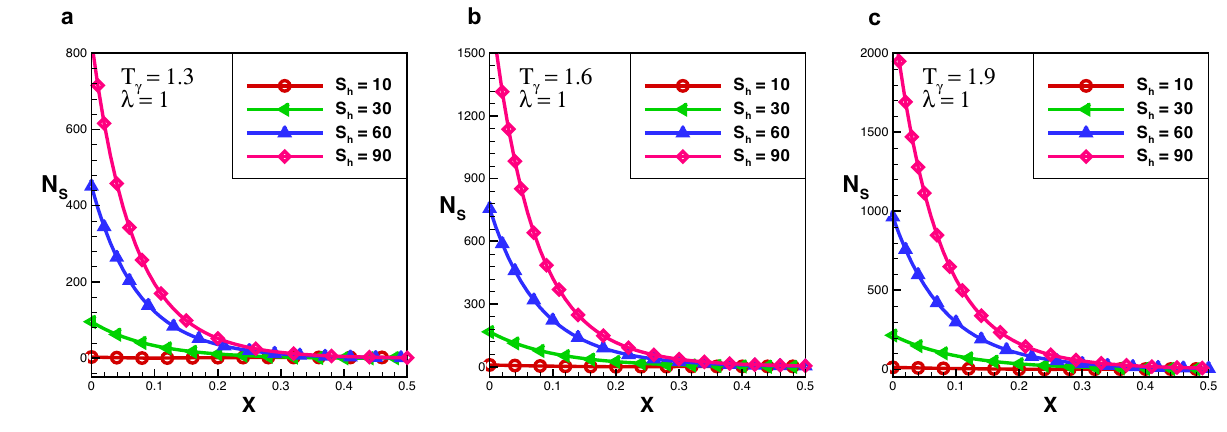
Figure 9. Entropy generation number in growing exponential porous fin for (cid:31) = 1 .